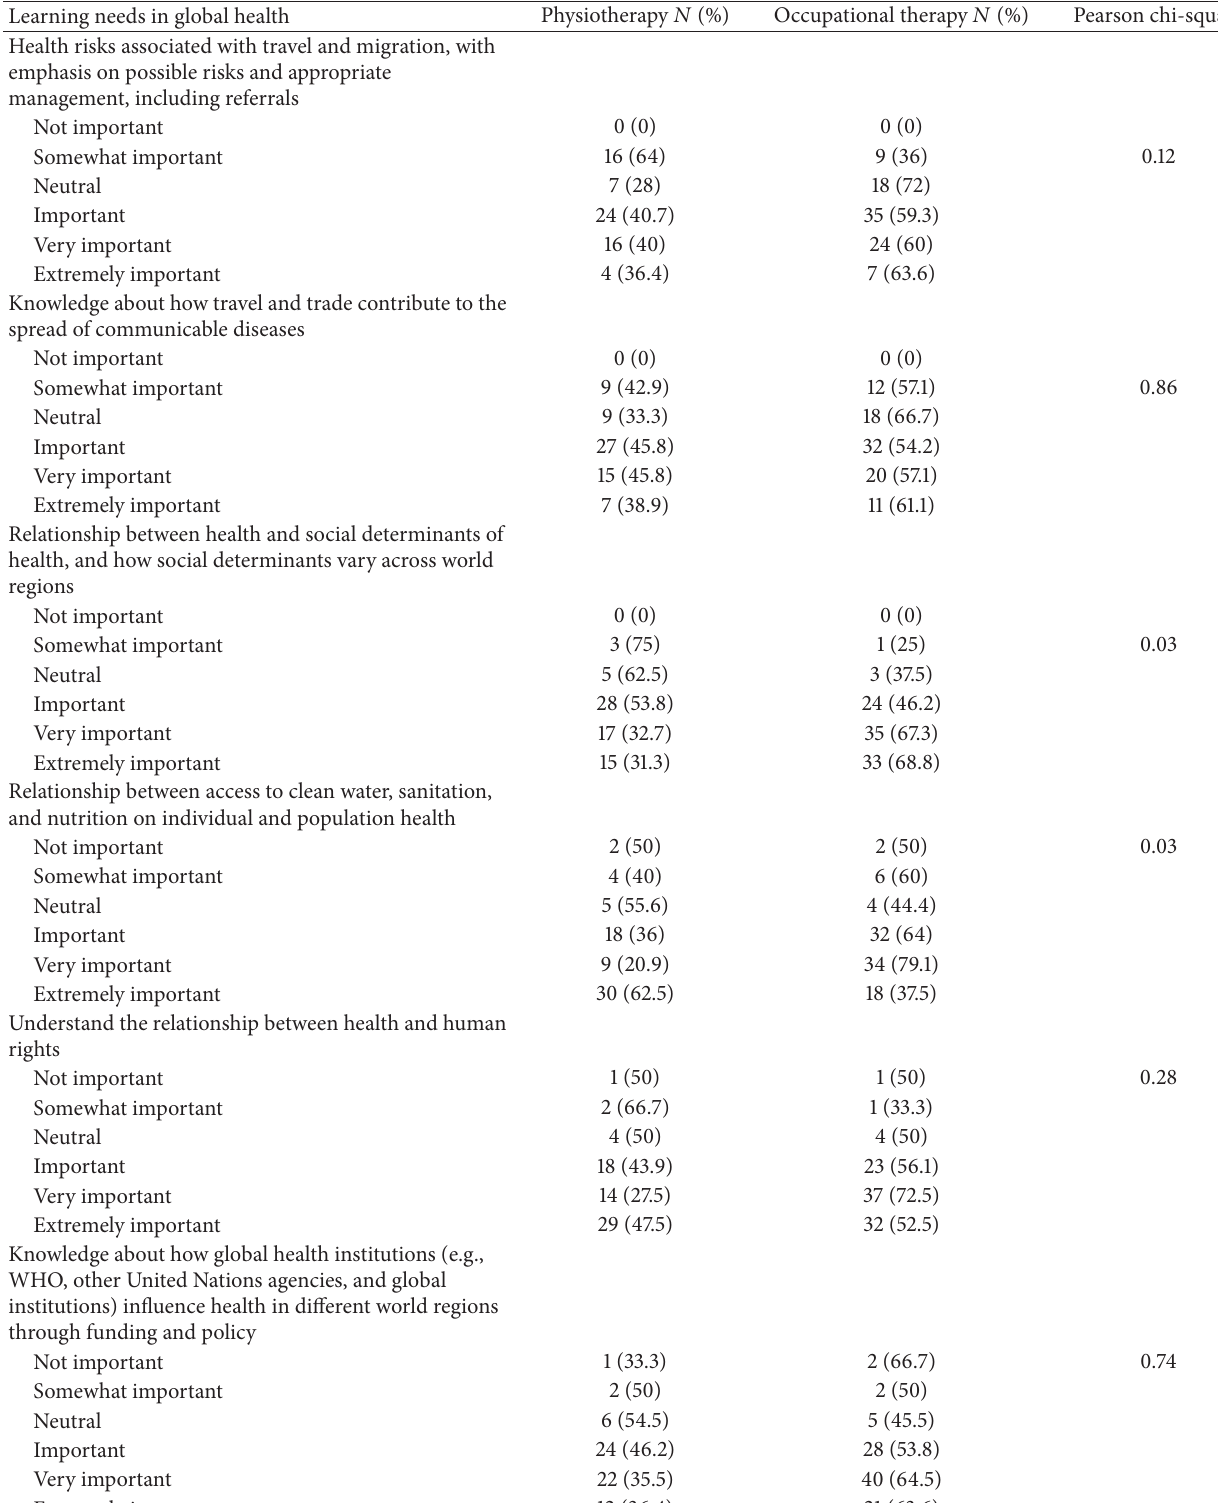
Table 4: Learning needs in global health for physiotherapy and occupational therapy students in Ontario, Canada. Learning needs in global health Physiotherapy 𝑁 (%) Occupational therapy 𝑁 (%) Pearson